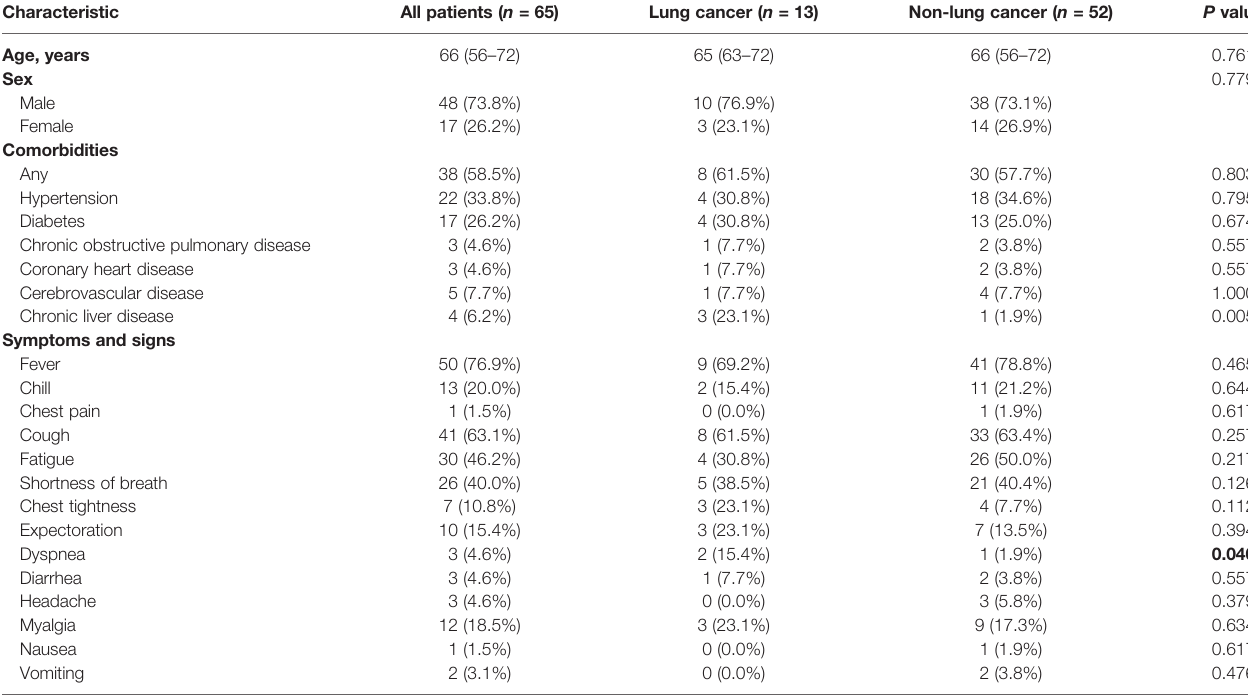
Bold value of p-value means P < 0.05. treatment within past 3 months. The percentage of medium-